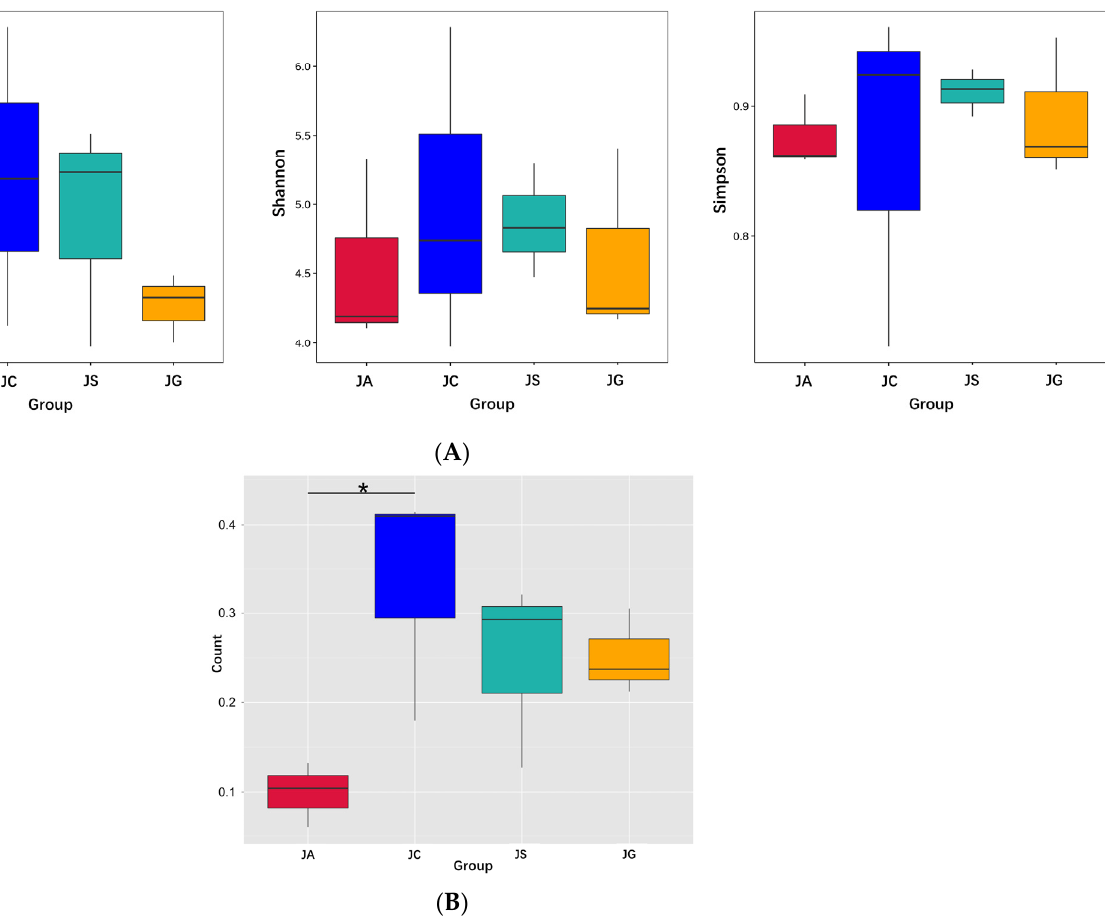
Figure 8. Diversity of intestinal microbiota: ( A ) Alpha diversity index of intestinal microbiota; ( B ) beta diversity index (weighted Unifrac). n = 3 per group. JC, control; JA, ALI; JS, LP-cs; JG, LP-cs-Gel. * p < 0.05.